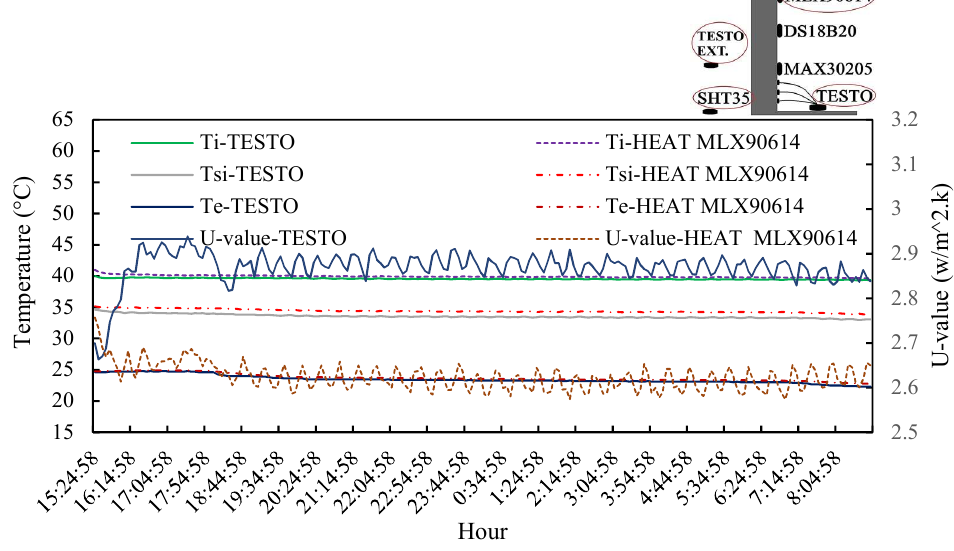
Figure 15. Comparison between the results of the HEAT MLX90614 and TESTO 435-1 in terms of T i , T e , T si , and the